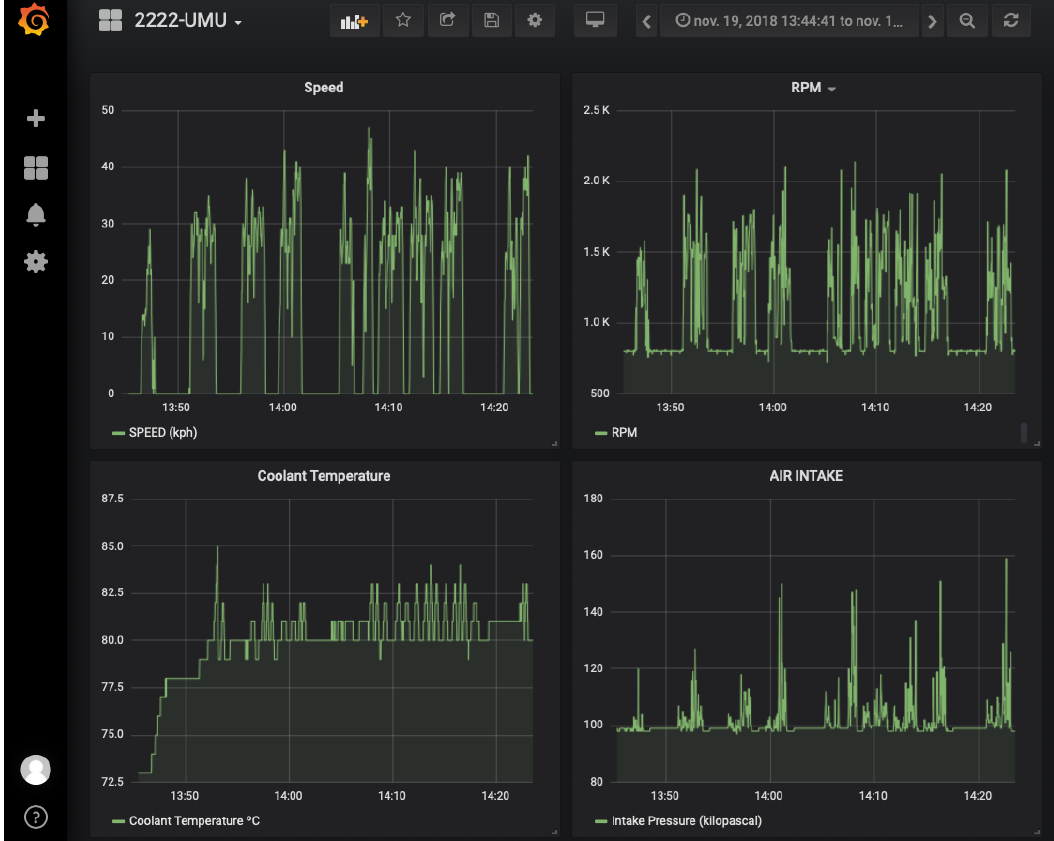
Figure 5. Screenshot of the Grafana view for monitoring vehicles.